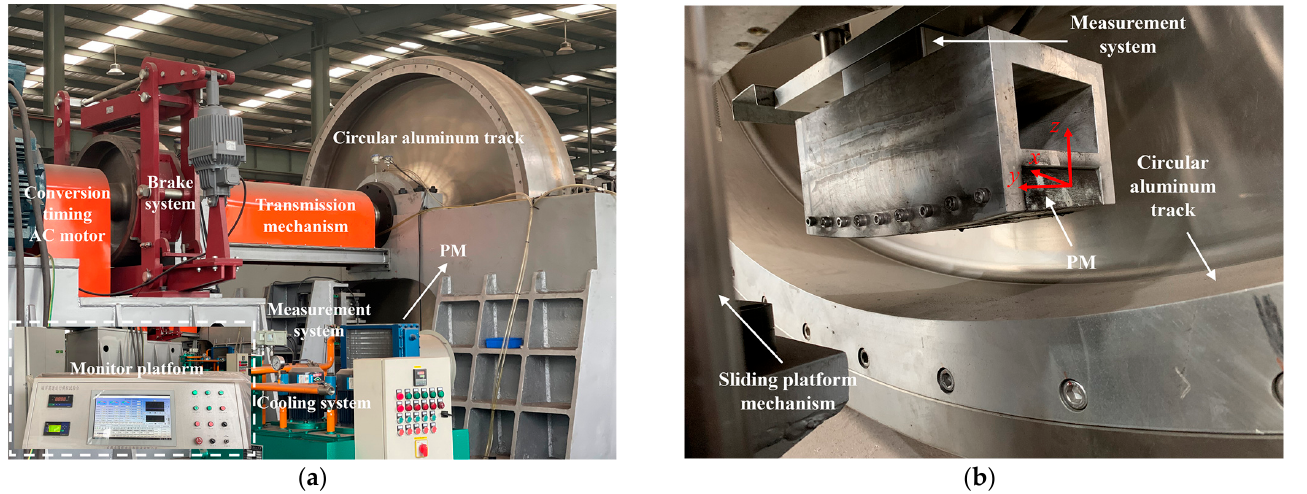
Figure 4. Photos of the PM EDS high-speed rotating experimental platform: ( a ) Overall schematic diagram of the device; ( b ) Schematic diagram of crucial parts.